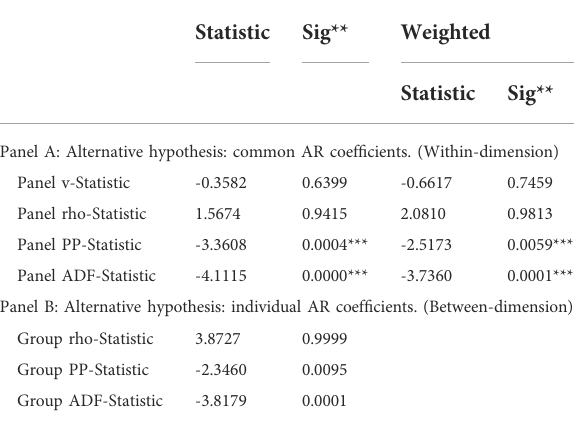
TABLE 4 Pedroni panel cointegration test. TABLE 5 Kao panel cointegration